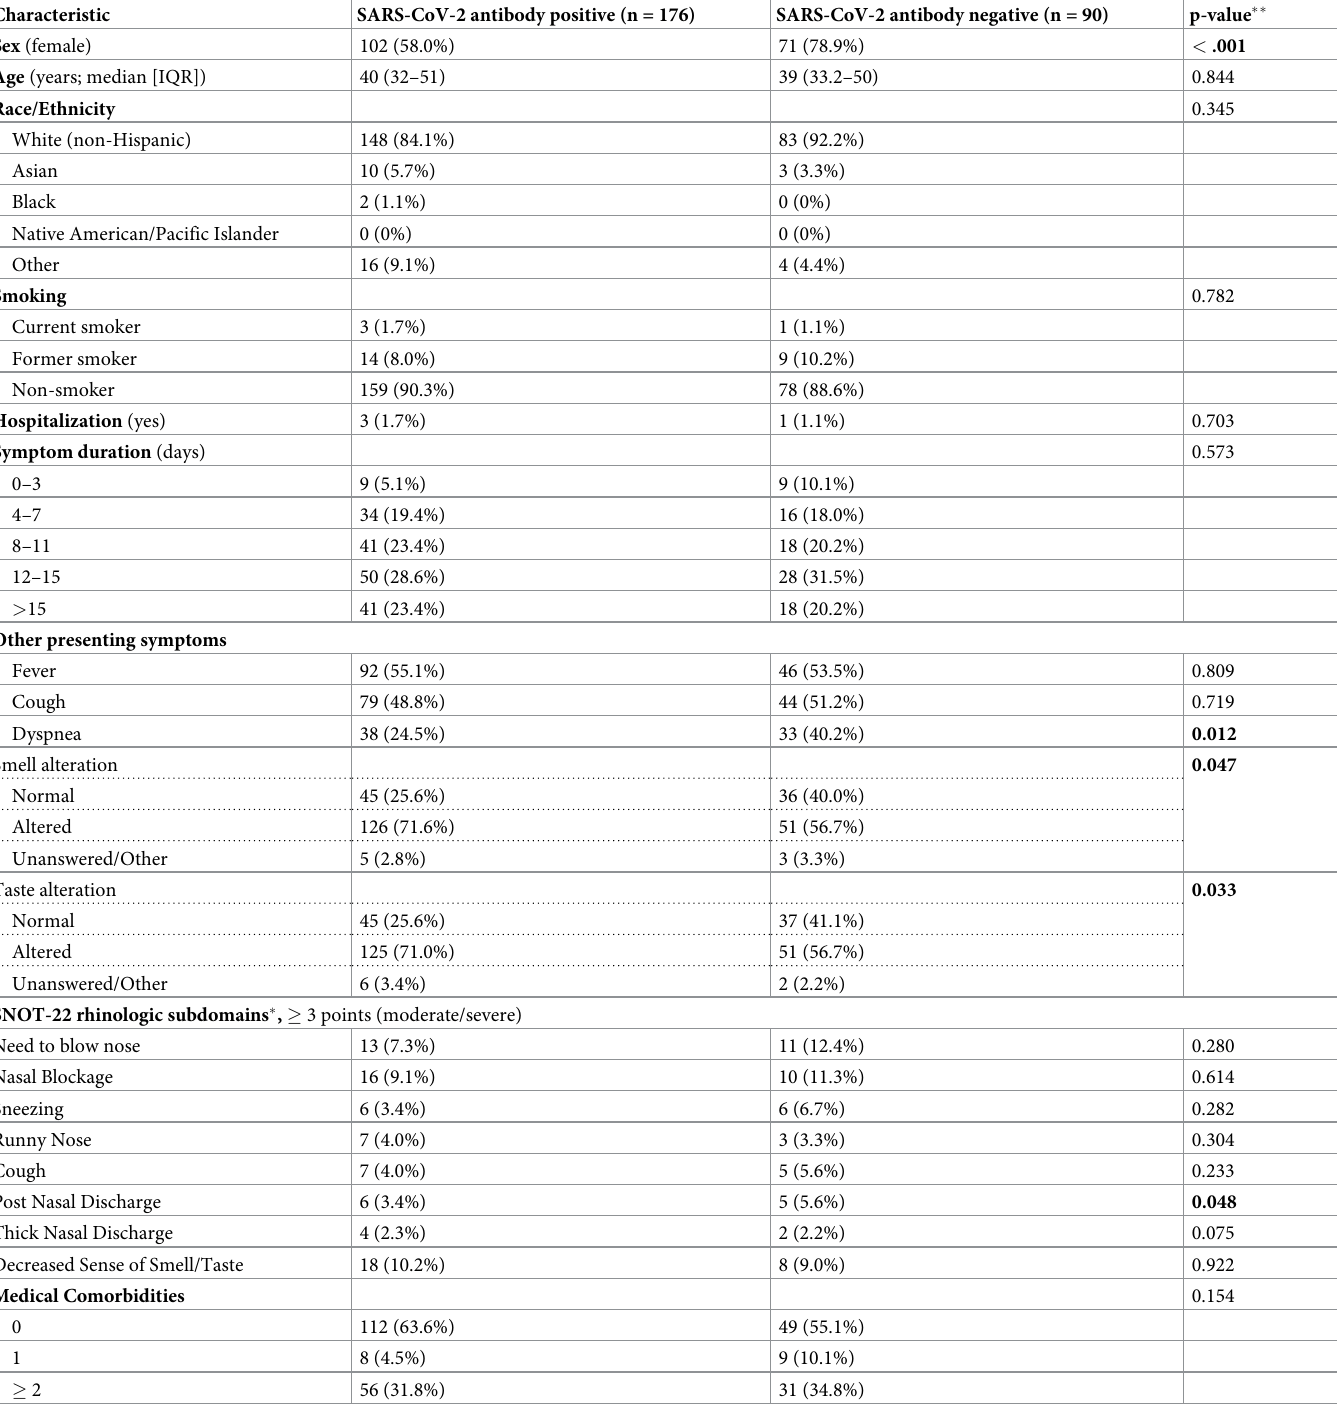
Table 2. Baseline characteristics by SARS-CoV-2 antibody response (n =